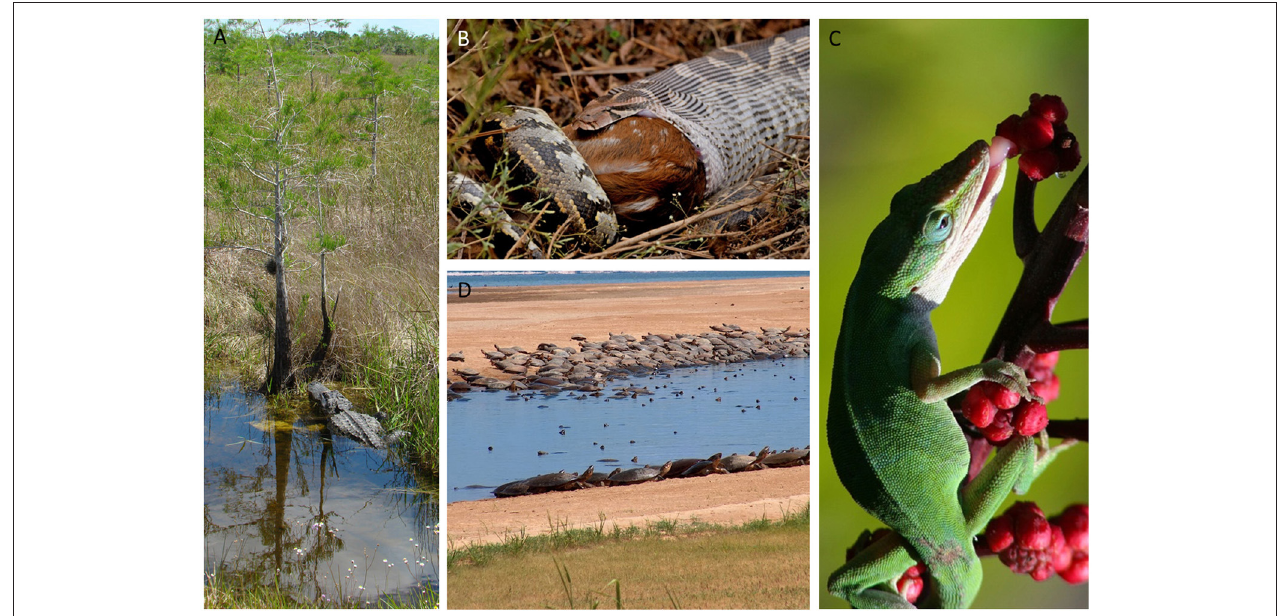
FIGURE 1 | Examples of reptiles’ roles in regulating ecological processes: In (A) an alligator ( Alligator mississipiensis ) lies in the hole it built to spend the dry season ( Palmer and Mazzotti, 2004)—as this also serves as water source to many other species, the reptile is acting as an ecosystem engineer (Photo: Anita Gould). (B) A Burmese python ( Python molurus ) feeds on a spotted deer ( Axis axis ); pythons are known to exert top down pressure ( Dorcas et al., 2012), limiting prey species population sizes (Photo: Rakesh Kumar Dogra). Lizards can act as pollinators ( Olesen and Valido, 2003); (C) a green anole ( Anolis carolinensis ) feeds on umbrella tree ( Schefflera actinophylla ) nectar (Photo: Leigh Hilbert). Tabuleiro do Embaubal, Brazil in (D) —Twenty thousand nesting Amazon giant river turtle ( Podocnemis expansa ) aggregate on this one beach each year (Miorando et al., 2015), representing a considerable nutrient input and transfer from the aquatic to terrestrial ecosystem (Photo: S.